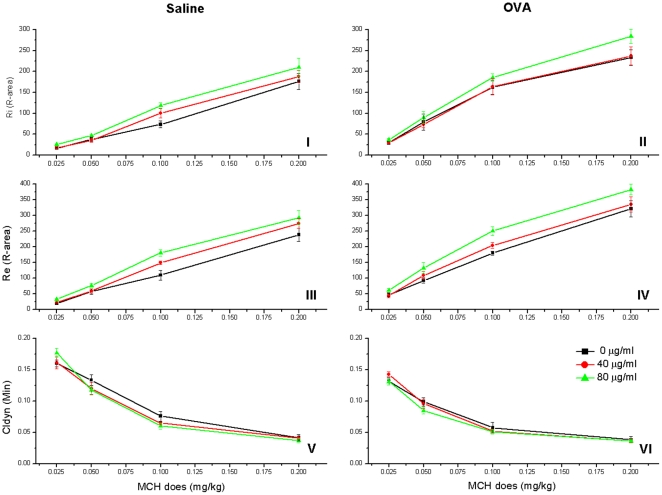
AHR assessment.I & II: Ri of saline groups and OVA groups, FnanoSiO2 = 6.460 (p = 0.002) and FOVA = 64.898 (p = 0.000). III & IV: Re of saline groups and OVA groups, FnanoSiO2 = 19.059 (p = 0.000) and FOVA = 83.118 (p = 0.000). V & VI: Cldyn of saline groups and OVA groups, FnanoSiO2 = 0.597 (p = 0.552) and FOVA = 21.874 (p = 0.000).